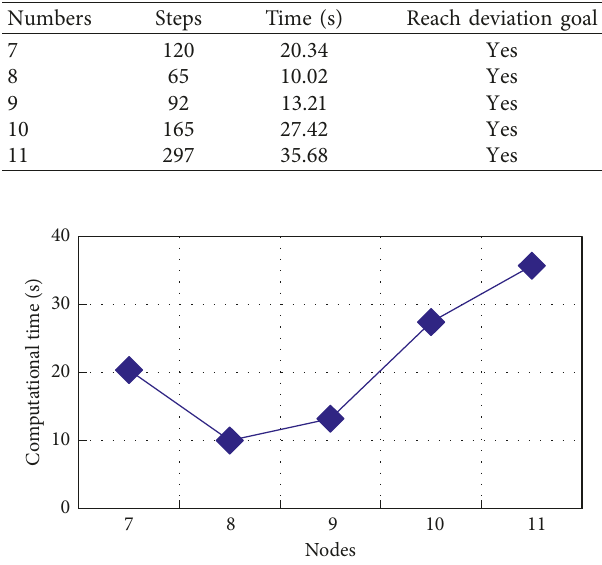
Figure 8: Computational consuming time on the different number of nodes in the hidden layer.